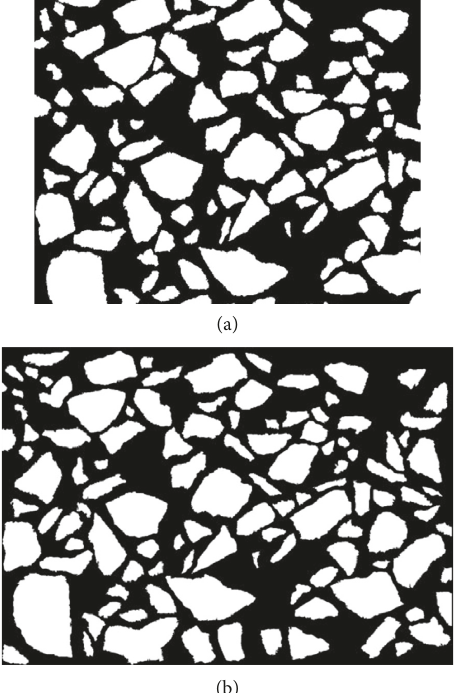
Figure 13: (a) Aggregate particles before the rutting test; (b) ag- gregate particles after the rutting test.